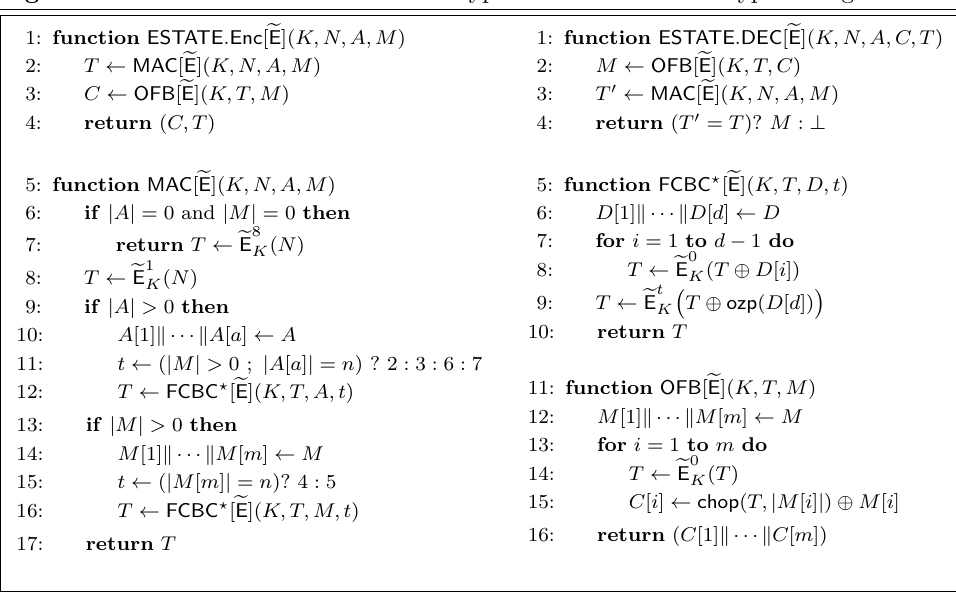
Algorithm 1 ESTATE Authenticated Encryption and Verified Decryption